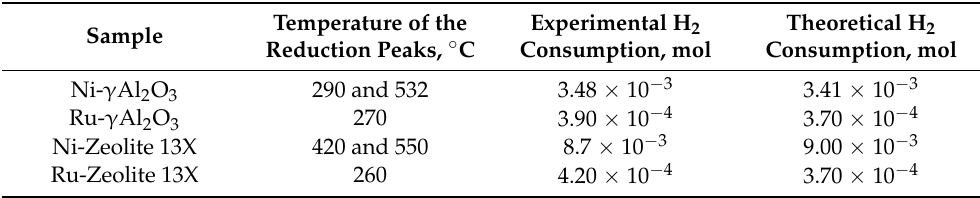
Table 2. Reduction peaks, experimental, and theoretical H 2 consumption for the prepared catalysts as results of the H 2 -TPR.